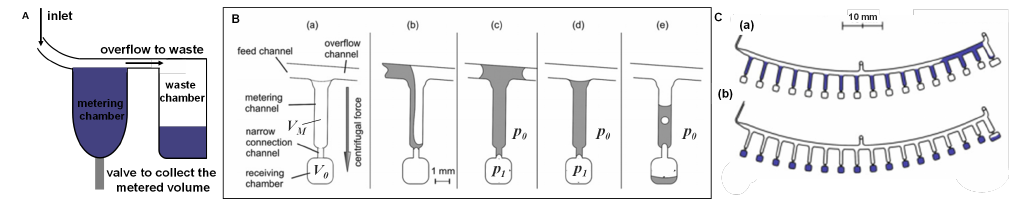
Figure 7. ( A ) Simple metering design based on overflow. ( B ) Metering structure based on